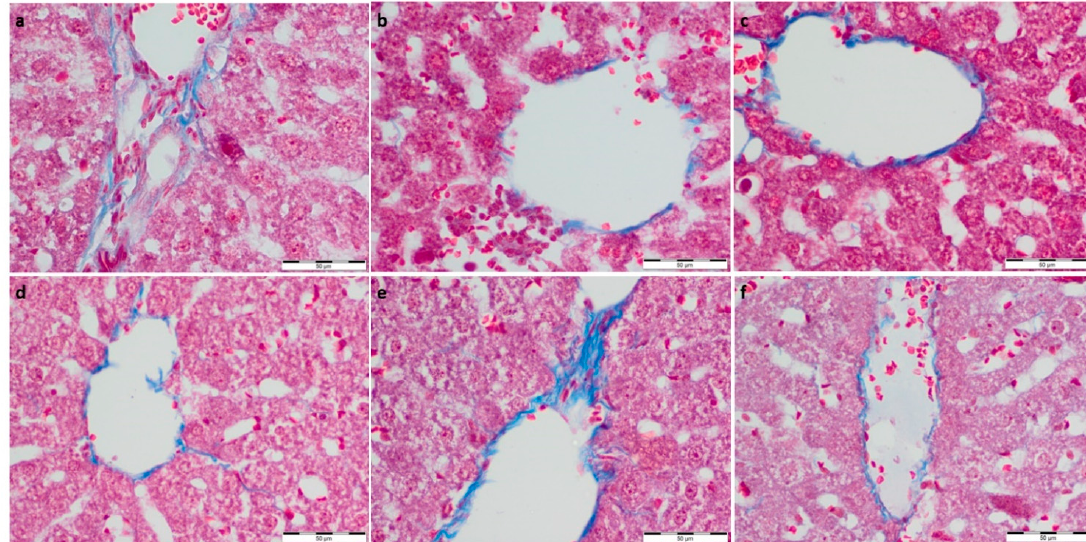
Figure 1. ( a ) Con-Sed, ( b ) Con-Run, ( c ) WP-Sed, ( d ) BP-Sed, ( e ) WP-Run and ( f ) BP-Run; BP-Run; Periodic acid Schiff; Glycogen was visualized using the periodic acid-Schiff reagent; Statistical decrease in glycogen deposition is visible in all experimental group compared to the Con-Sed group.